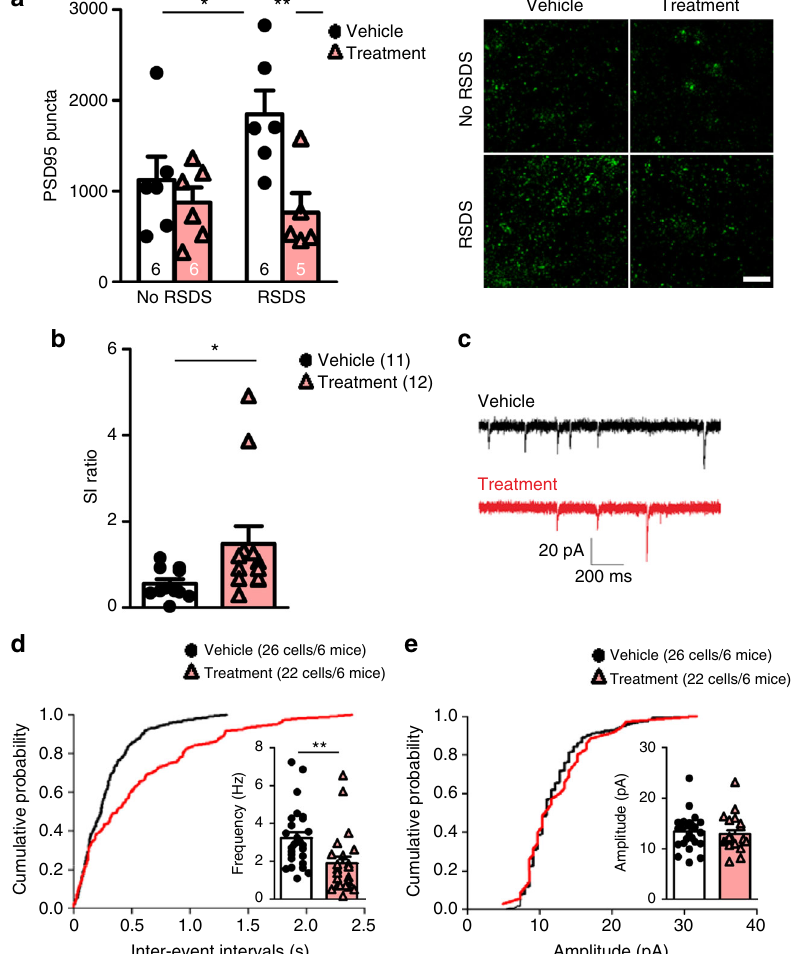
Fig. 4 Prophylactic treatment with DHCA/Mal-gluc reverses RSDS-induced synaptic structural and functional alteration in the NAc. a Immunochemistry quanti fi cation of PSD95 puncta in NAc (one-way ANOVA, F 3,22 = 4.50, P = 0.015). Inset; representative images of PSD95 puncta, scale bar = 10 µ m. b – e DHCA/Mal-gluc treatment regulates synaptic transmission in D2 neurons in the shell of NAc following RSDS. b Social avoidance test in the Drd2 mice (two-tailed unpaired t -test, t 21 = 2.114, P = 0.047). c Representative traces of mEPSCs. d mEPSCs frequencies (two-tailed unpaired t -test, t 46 = 2.890, P = 0.0059). e mEPSCs amplitudes (two-tailed unpaired t -test, t 46 = 0.5008, P = 0.6189). All graphs represent mean ± s.e.m., * P < 0.05, ** P <